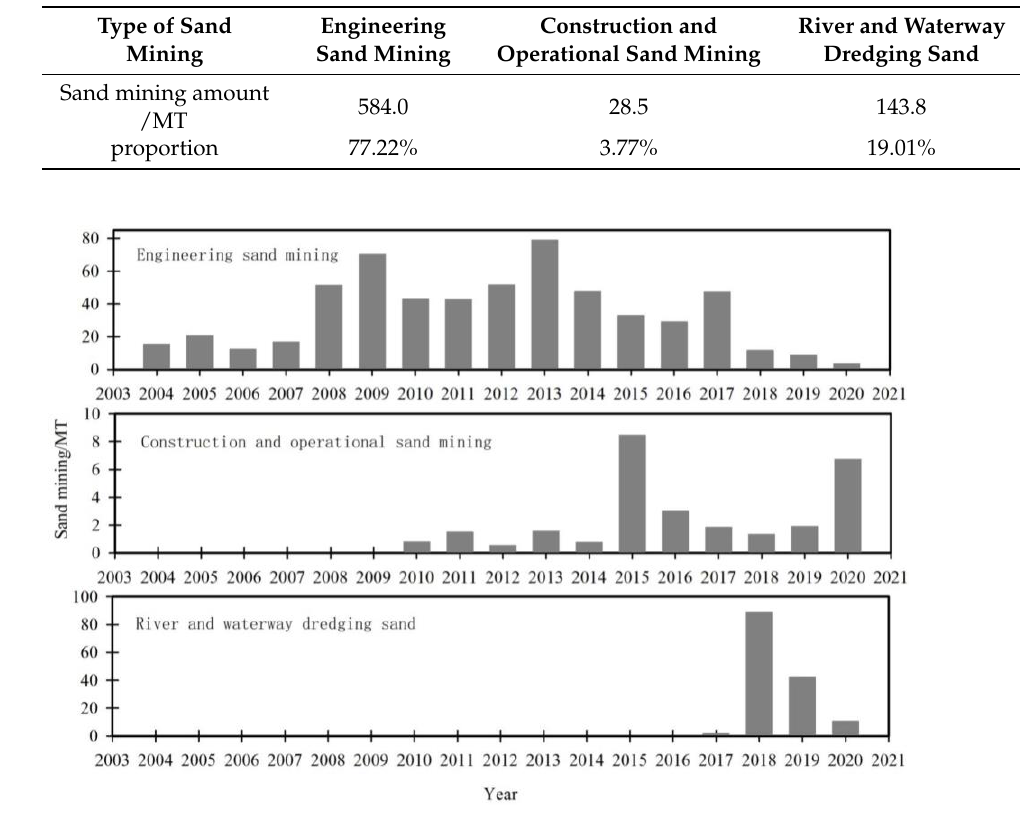
Table 6. Total sand mining data of different user types in the mainstream of the YR.